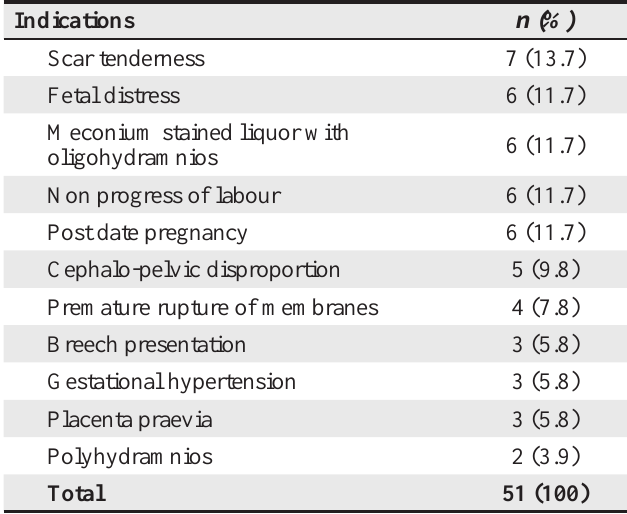
Table 4 . Indications for repeat CS